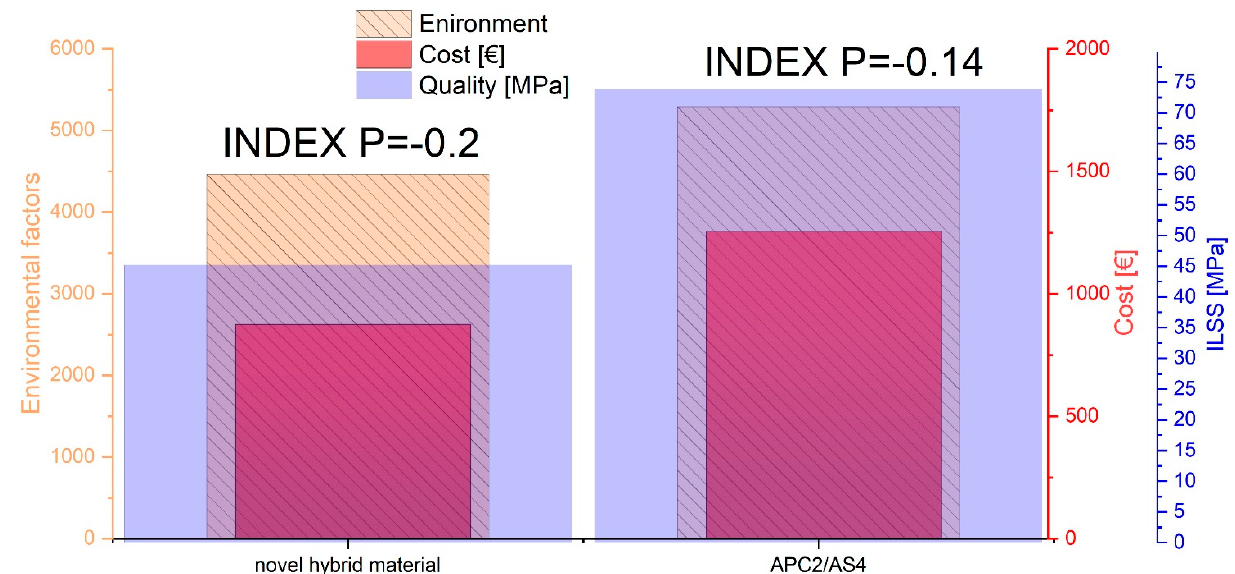
Figure 10. Overall comparison of the materials investigated.